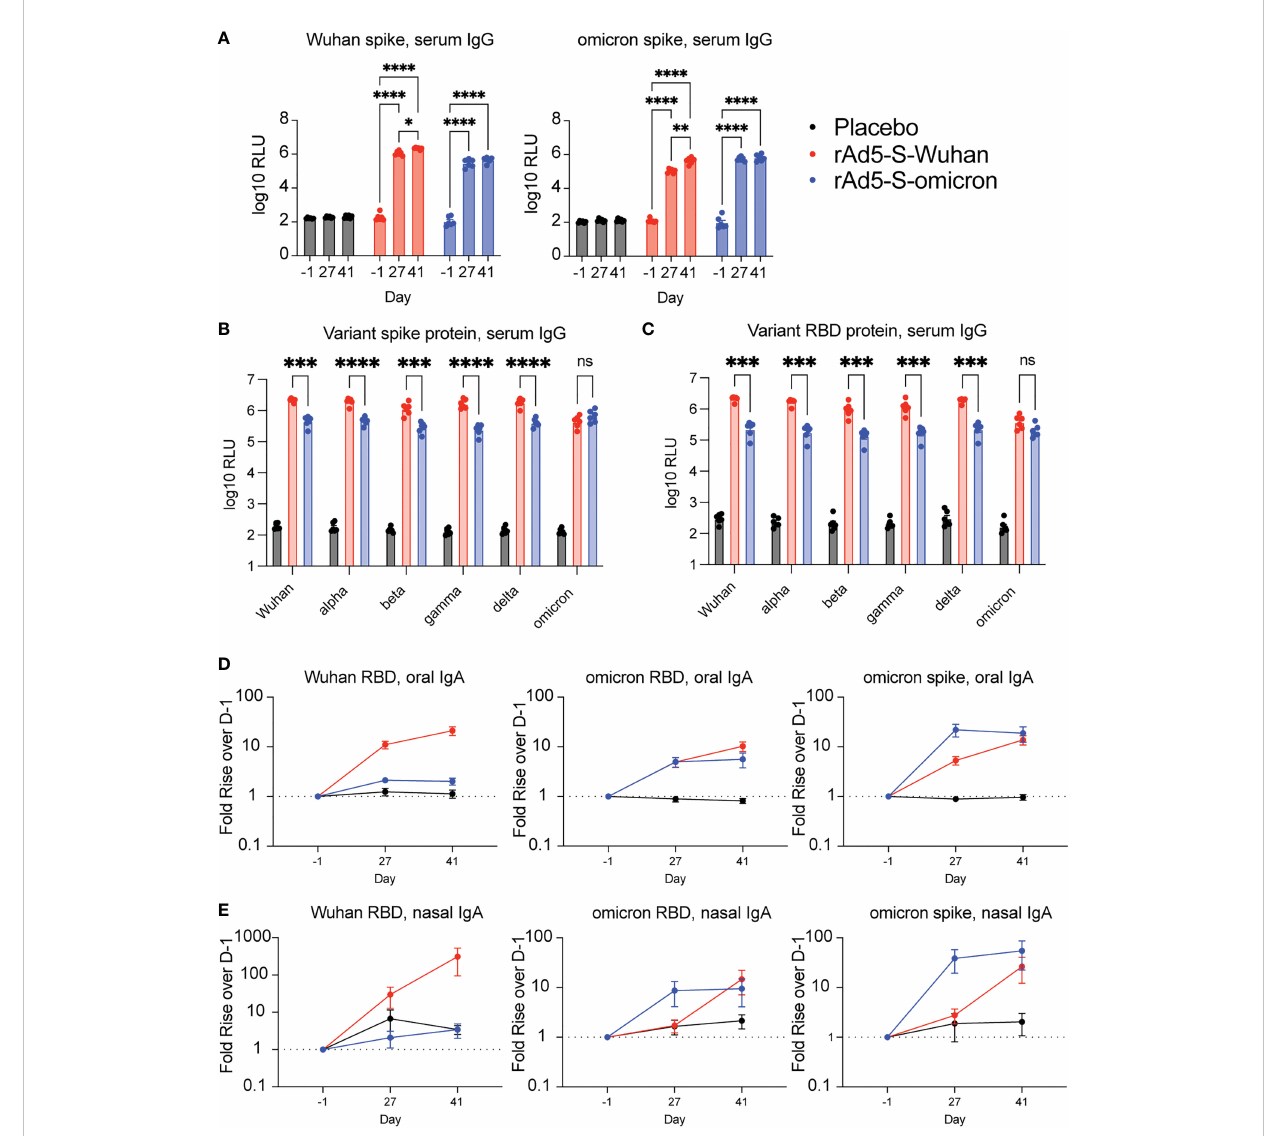
FIGURE 2 Serum and mucosal antibodies from Wuhan- and omicron-based vaccination. (A) Serum IgG from hamsters vaccinated with rAd5-S-Wuhan (red), rAd5-S-omicron (blue), or placebo (black) prior to vaccination (D-1), prior to boost (D27) and two weeks after boost (D41). (B, C) Levels of serum IgG to spike (B) and RBD (C) of SARS-CoV-2 VOC at D41 post prime vaccination. (D) IgA from oral swab eluates and (E) nasal washes at indicated times. Antibody signals were normalized to total IgA and plotted as fold rise of D-1. Mean and SEM plotted. 2-way ANOVA with a Geisser-Greenhouse correction and with Tukey ’ s multiple comparison test. *p < 0.05, **p < 0.01, ***p < 0.005, ****p < 0.0001. ns, not signi fi